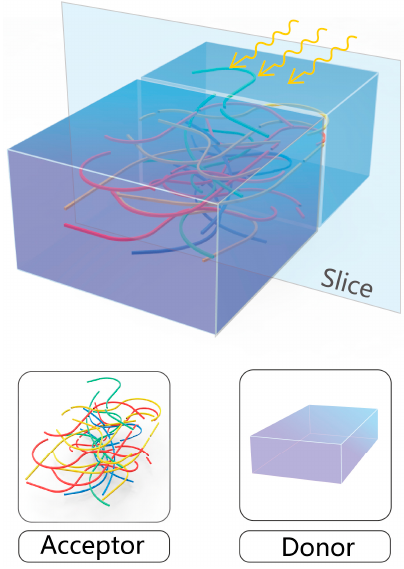
Figure 1. Diagrammatic layout of a bulk heterojunction solar cell.